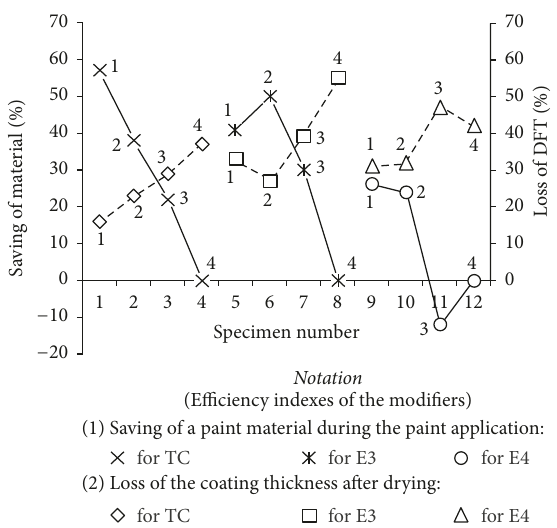
Figure 6: Assessment of a comparative consumption of the paint materials with and without use of the modifiers.